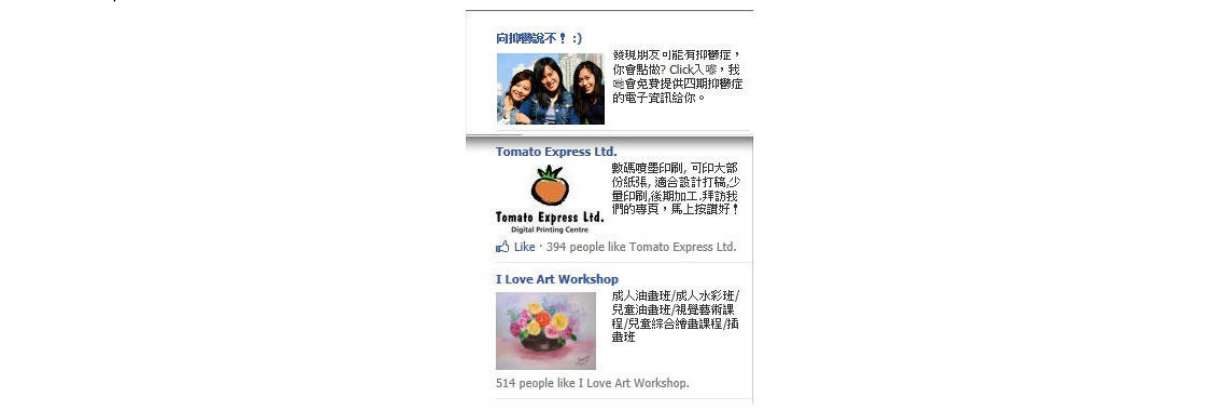
Figure 2. Example of the Facebook